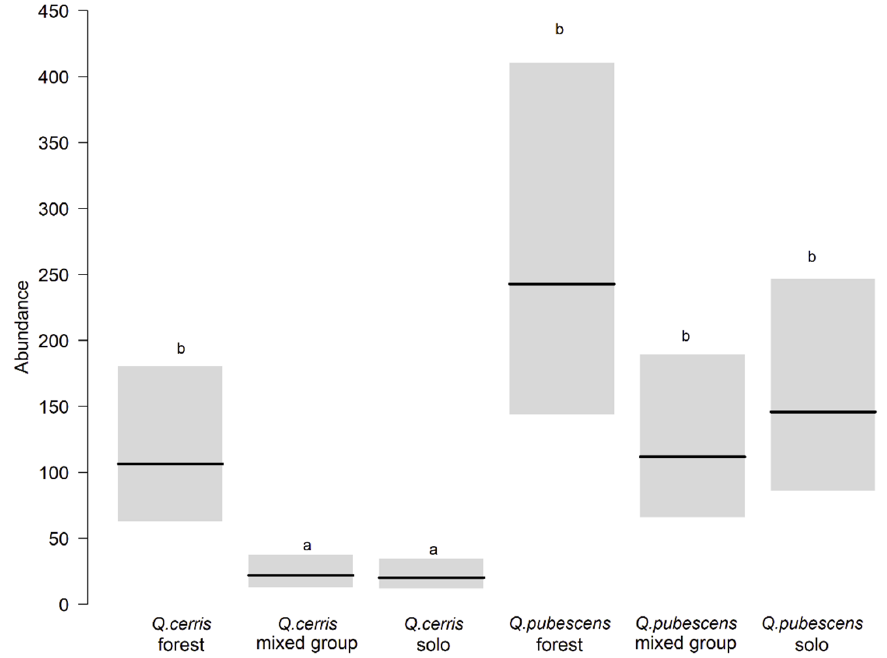
Figure 4. Abundance of Agriopis leucophaearia caterpillars (number of individuals on three branches, each 1 m long) on mature LF Quercus cerris and EF Q. pubescens located in the forest interior (forest) and out of it, in mixed tree groups composed of Q. cerris and Q. pubescens , and on lone (solo) trees. A horizontal line denotes the mean, and bars the 95% confidence intervals. Distinct letters above columns indicate a significant difference.